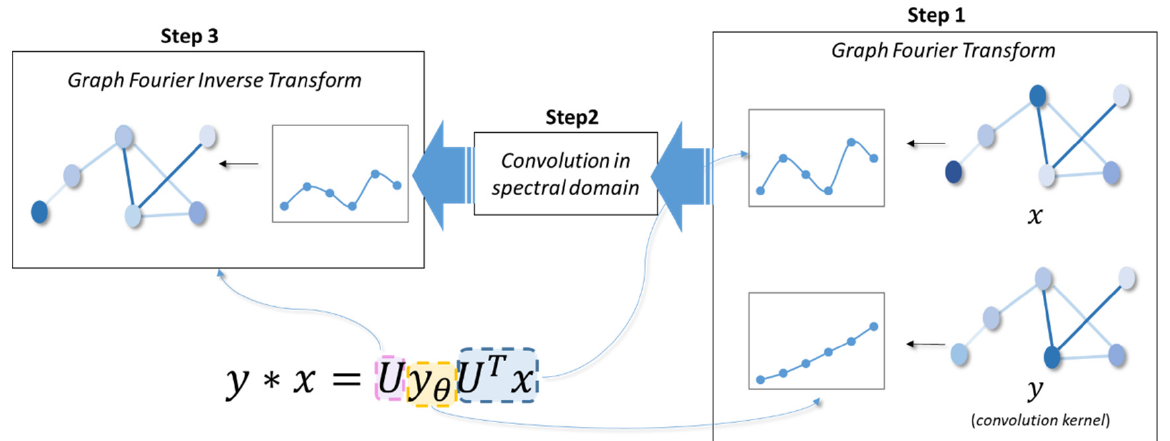
Figure 4. Graph convolution in the spectral domain.